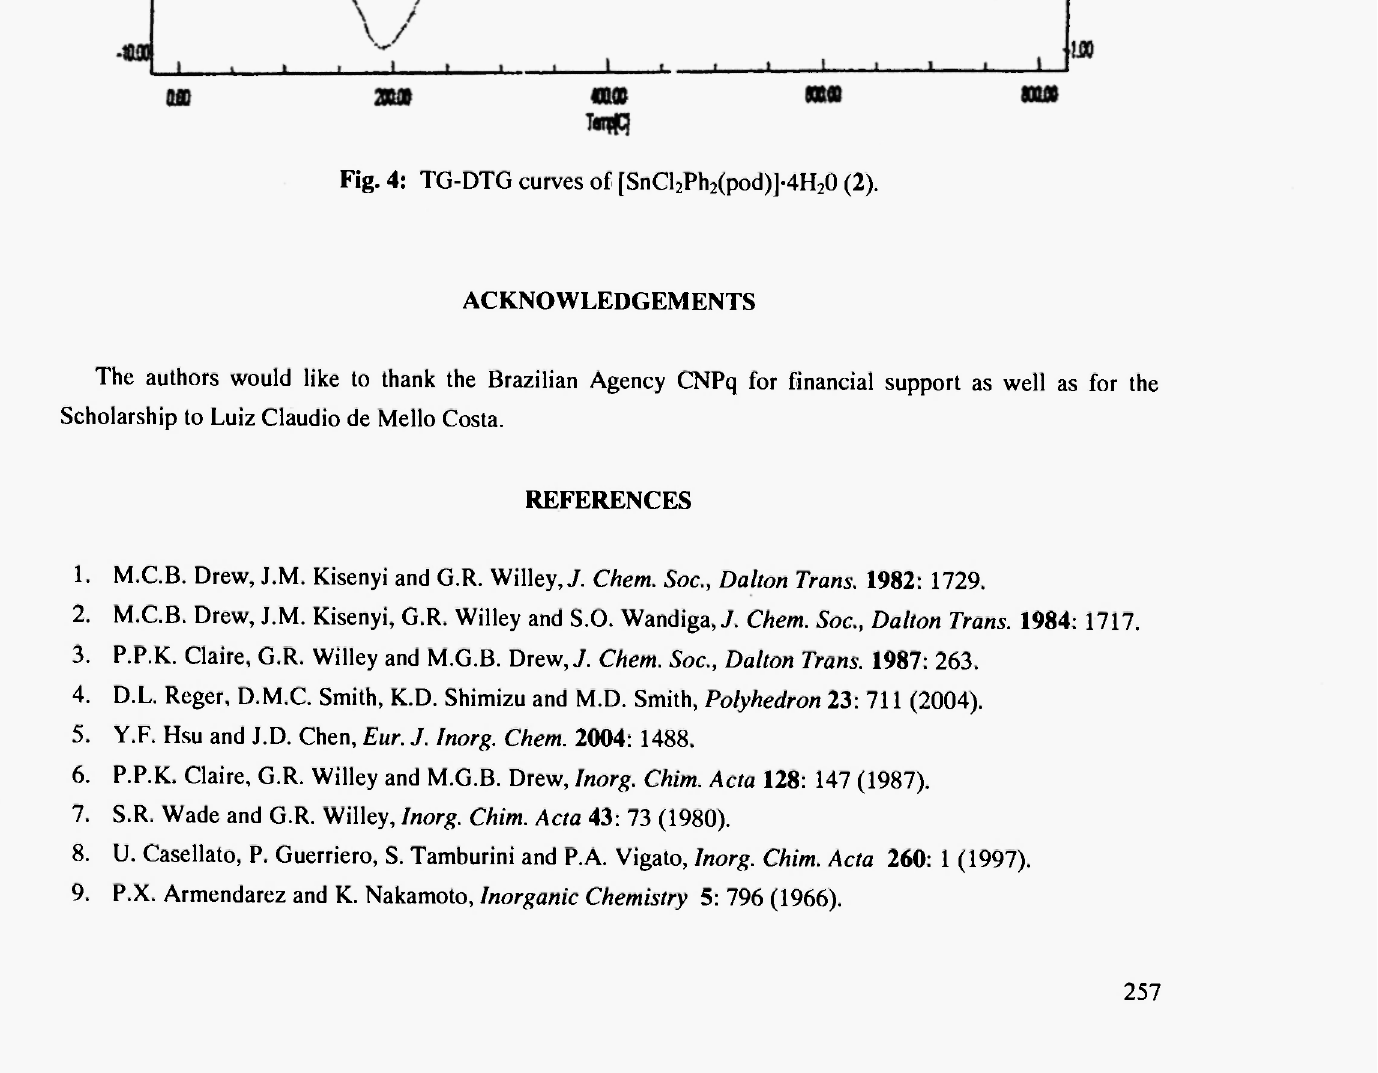
Fig. 4: TG-DTG curves of [SnCl 2 Ph 2 (pod)]-4H 2 0